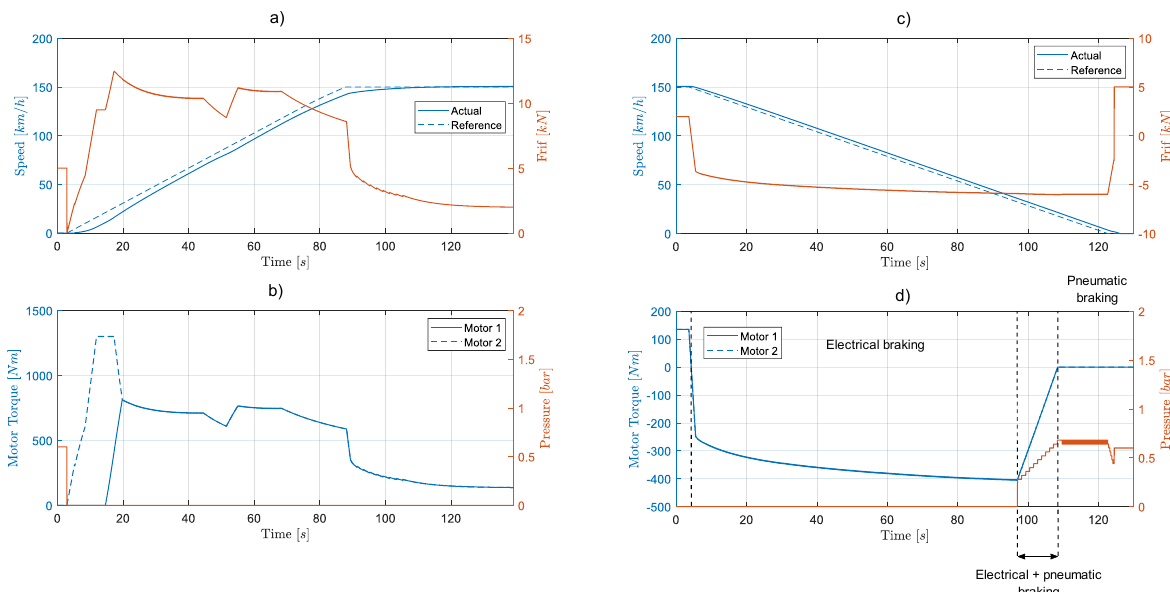
Figure 14. Simulation results in terms of speed of the vehicle and internal force reference ( a , c ), motor drive torques and pressures of the pneumatic brake system ( b , d ). The results are related to the acceleration phase ( a , b ) and deceleration phase ( c , d ).